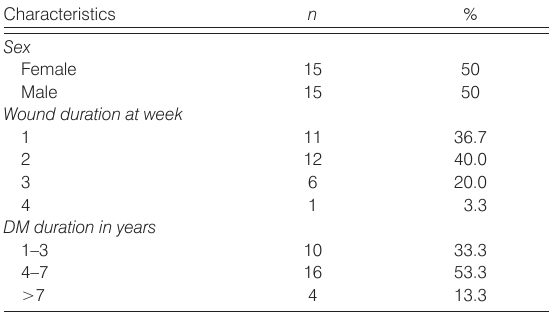
Table 1. Participant characteristics.